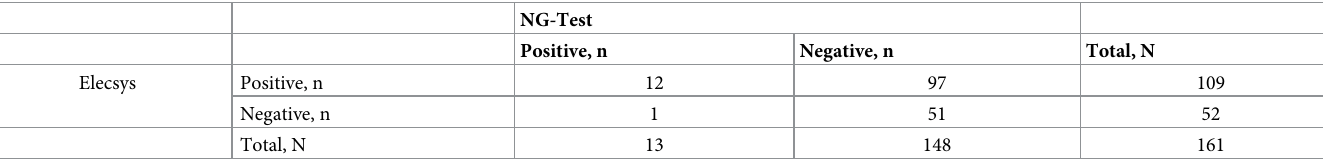
Table 3. Test agreement between NG-Test and Elecsys in 161 samples in MSF Aden Trauma Center–January